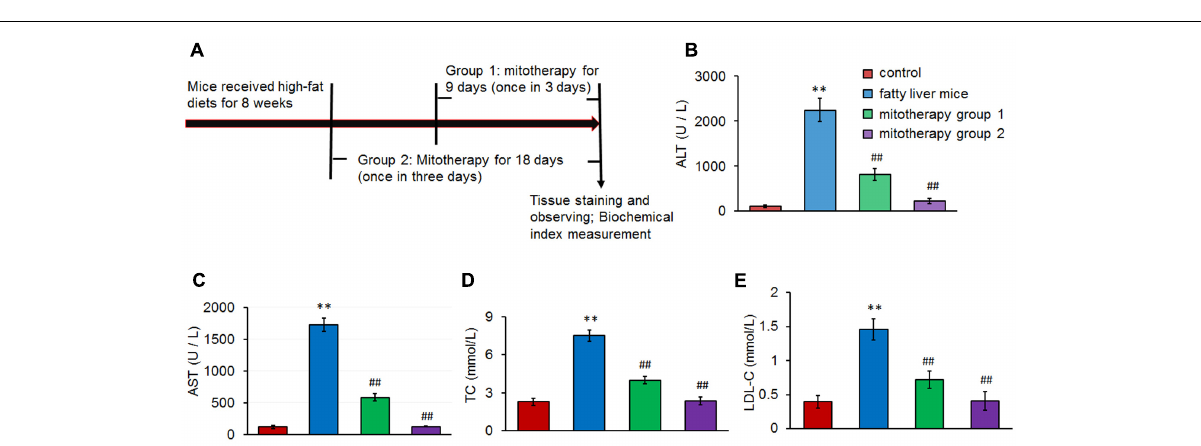
FIGURE 3 | Serum transaminase and lipid levels in the mice treated with high-fat diets and mitochondria. (A) Experimental protocol of mitotherapy for mouse fatty liver induced by high-fat diets. (B) ALT activity. (C) AST activity. (D) TC level. (E) LDL-C level. Data were expressed as mean ± SEM ( n = 10 mice for each group). ∗∗ p < 0.01 compared with the control; ## p < 0.01 compared with the fatty liver